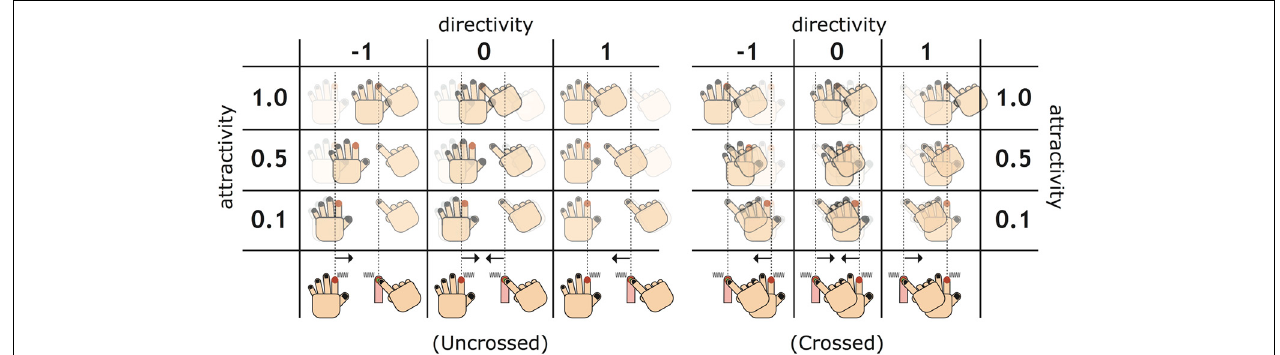
FIGURE 4 | Diagram for understanding new measures: attractivity and directivity. The attractivity indicates how strongly two fingers are attracted after experiencing an illusion stage. The directivity measures the power